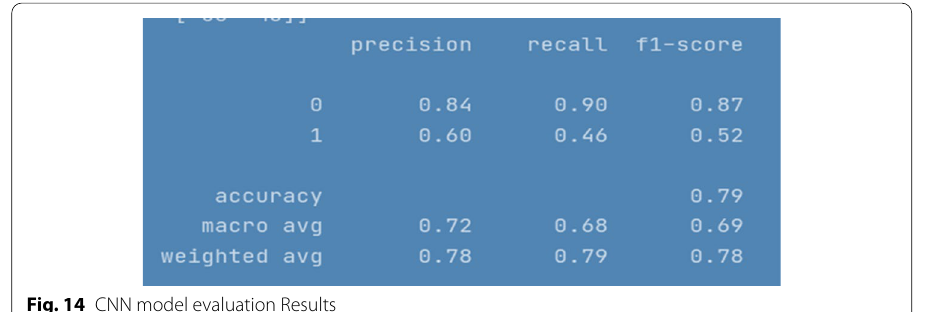
Fig. 14 CNN model evaluation Results